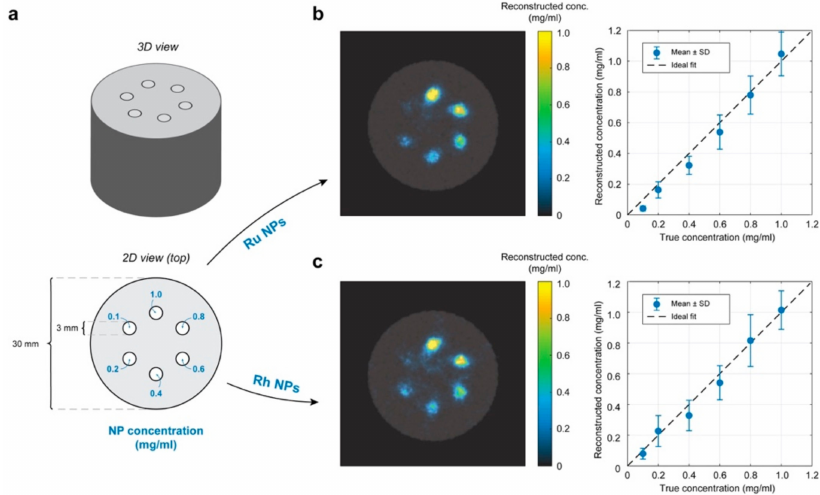
Figure 8. X-Ray fluorescence computed tomography (XFCT) contrast potential of Ru and Rh NPs in a small-animal sized phantom. ( a ) Physical phantom used to mimic a mouse. The phantom body is a 30 mm diameter 3D-printed water-filled cylinder. Cylindrical insets of 3 mm diameter are each filled with di ff erent concentrations of Ru and Rh NPs, respectively, for two separate tomographic scans. ( b ) Left ; Overlay of CT (gray-scale) and XFCT (color) reconstruction of an axial slice through the phantom. The cylindrical insets were filled with Ru NPs at di ff erent concentrations. Color bar represents the reconstructed concentration of Ru in the XFCT image. Right ; Average reconstructed concentration, including standard deviation (SD) in each cylindrical inset plotted against the true concentration. Ideal reconstruction represented with a black dashed line. ( c ) Same as ( b ) but for Rh